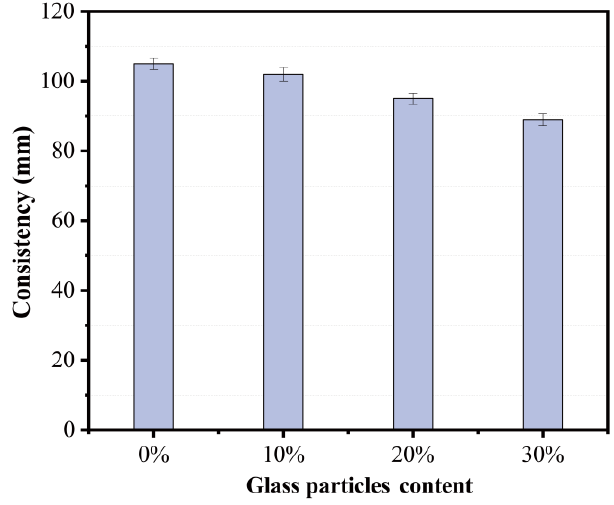
Figure 13. Effect of recycling glass content on mortar consistency.